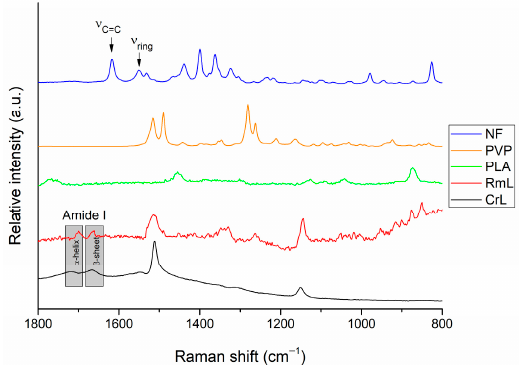
Figure 3. Raman spectra of initial components, NF, nadifloxacin; PVP, polyvinyl pyrrolidone; PLA, polylactic acid; RmL, lipase from Rizomucor miehei ; and CrL, lipase from Candida rugosa.